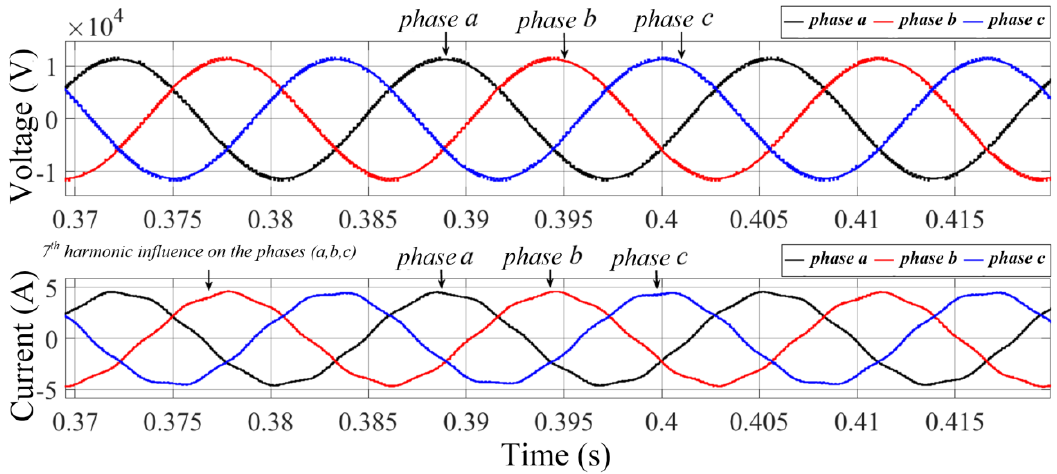
Figure 17. Voltage (upper, 10 kV / div) and current (lower, 5 A / div) in TUT with 3% 7th harmonic current injection. Horizontal axis: 5 ms / div.